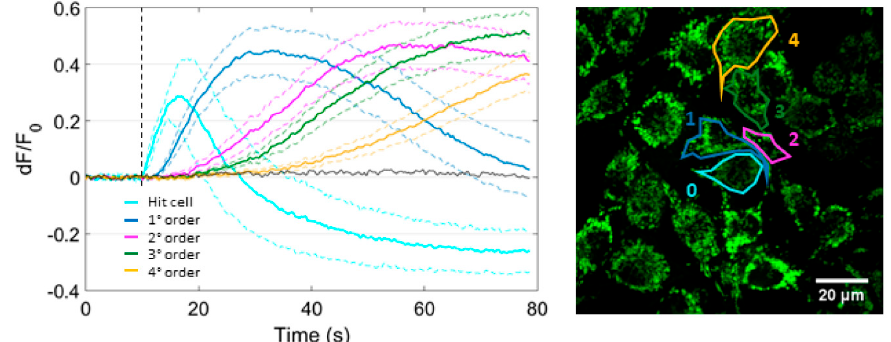
Figure 5. Focal irradiation of PS-loaded cells triggers an intercellular mitochondrial Ca 2+ wave. PS-loaded B16-F10 cell cultures expressing CEPIA2mt (a green fluorescent Ca 2+ biosensor targeted to mitochondria) were exposed to SS conditions (see Materials and Methods, Section 2.2). The graph on the left displays mean dF / F 0 fluorescence traces (solid lines) ± s.e.m. (dashed lined) computed as average of n = 4 independent experiments for each bystander cell order. Single-cell traces were obtained as average pixel signals within ROIs contouring the whole cell area, as shown in the fluorescence image on the right. The black trace is a representative result obtained in the absence of PS. The vertical dashed line marks the onset of laser irradiation.